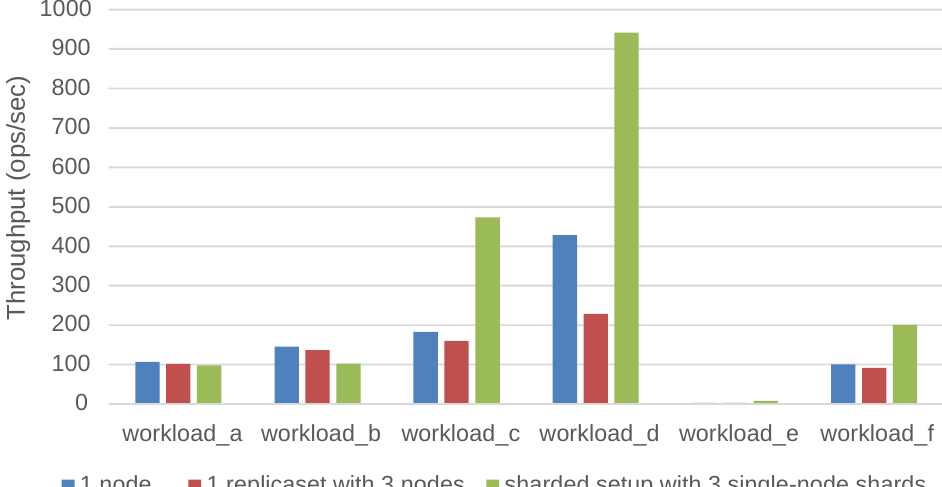
Figure 8. Impact of the deployment configuration on the throughput when the data does not fit in the cache of a stand-alone MongoDB database.